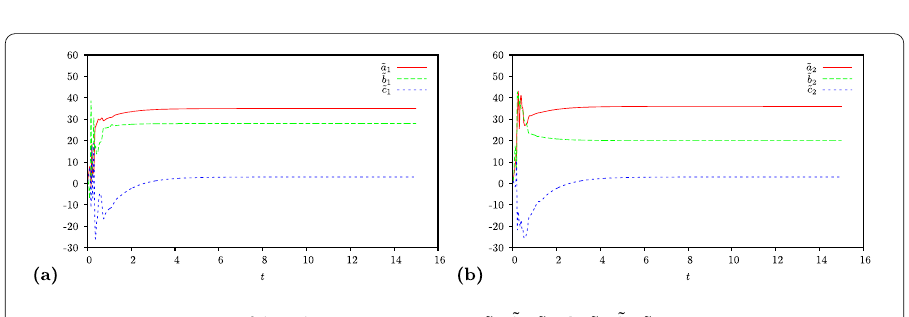
Figure 4 State trajectories of the adaptive parameters: ( a ) ˜ a 1 , ˜ b 1 , ˜ c 1 ; ( b ) ˜ a 2 , ˜ b 2 , ˜ c 2